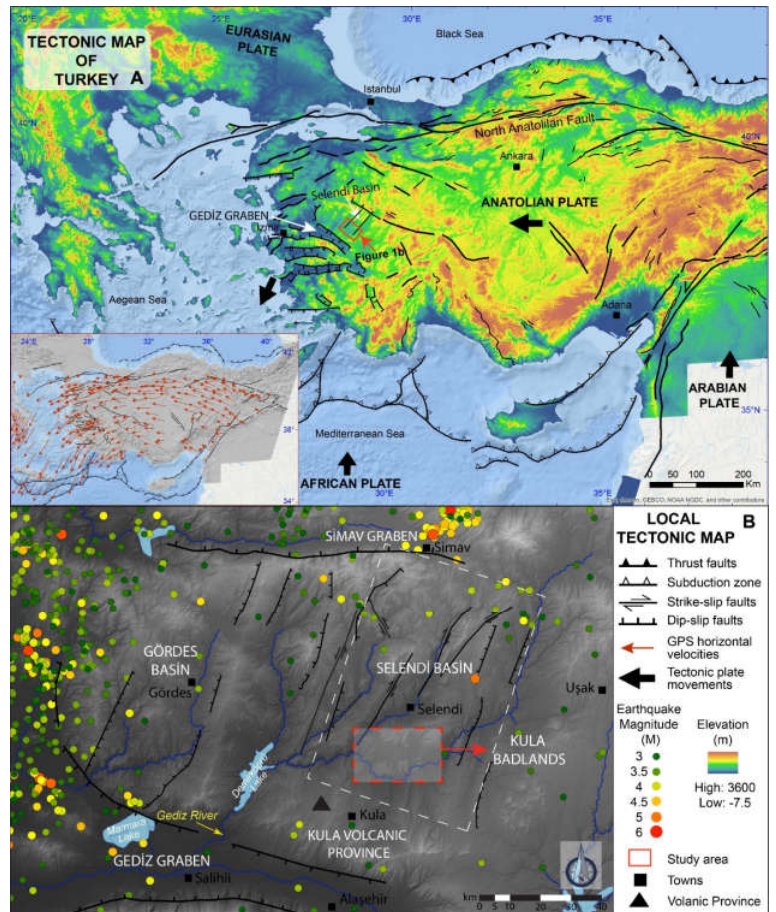
Figure 1. ( A ) Tectonic map of Turkey highlighting major tectonic units and showing location of the study area. Modified from [50–52]. The rotational tectonic frame with GPS-derived velocities modified from [53]. ( B ) Tectonic and location map of the Selendi Basin with major tectonic structures shown. Earthquakes of the past 40 years are also shown with magnitude. Digital Elevation Model at the courtesy of European Environment Agency (2020) [54]. Earthquake data acquired from USGS Earthquake Catalogue, 2020 [55].